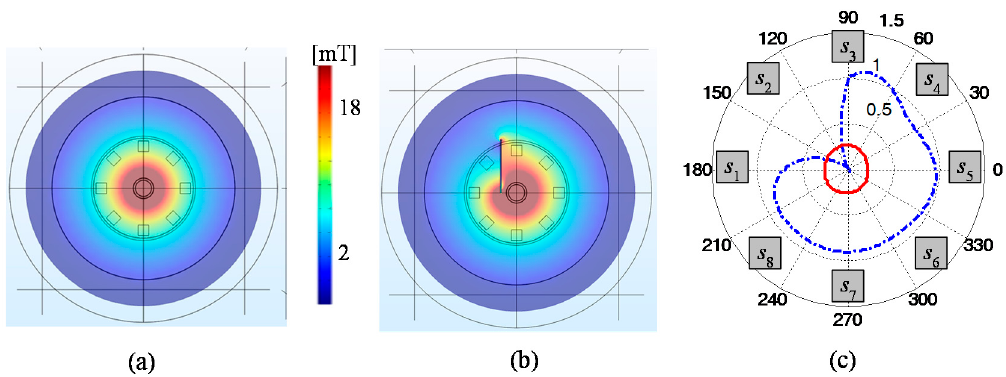
Figure 5. Selected results of flux distributions obtained during FEM simulations: ( a ) without defect; ( b ) with defect; ( c ) polar plot of the V z component of the flux sensed by the successive sensors normalized to maximum value.